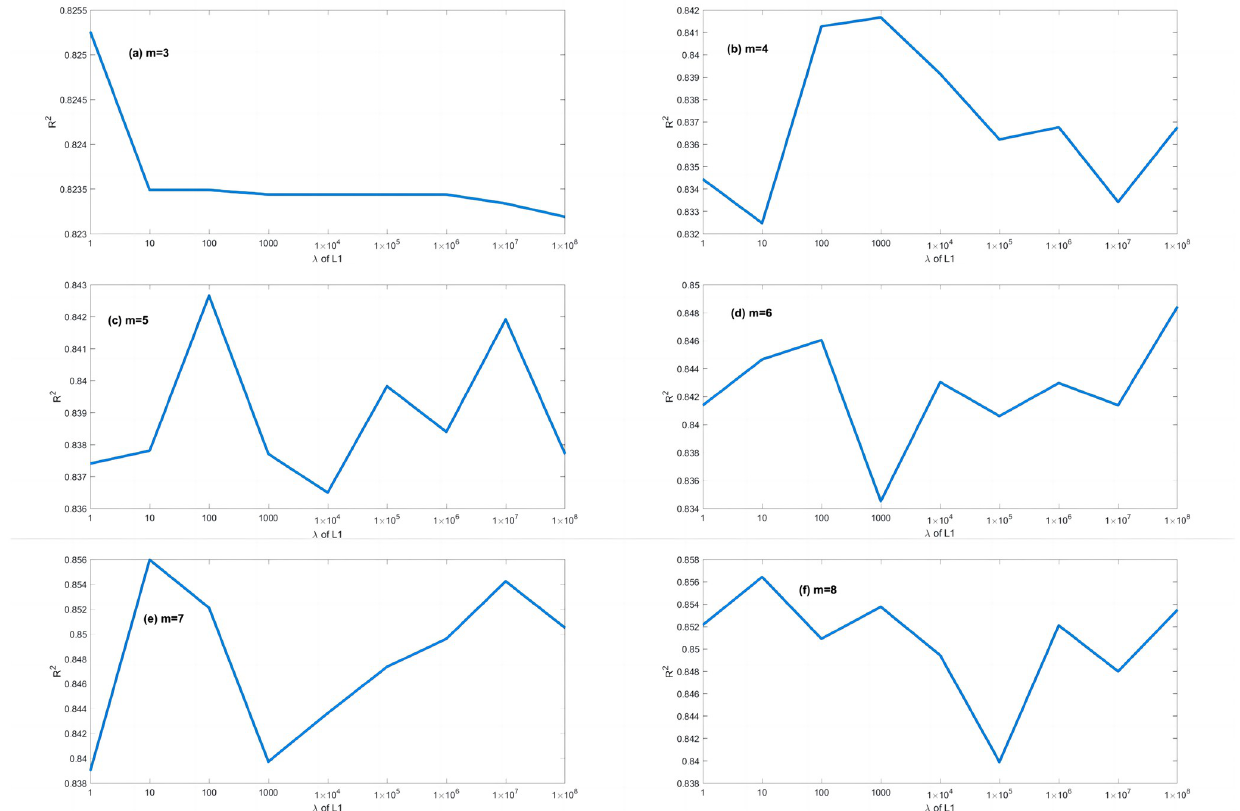
Fig 7. Comparison of EPR results (R 2 ) in different values of λ to L1RM (dataset 2). (a) m = 3, (b) m = 4, (c) m = 5, (d) m = 6, (e) m = 7 and (f) m = 8.